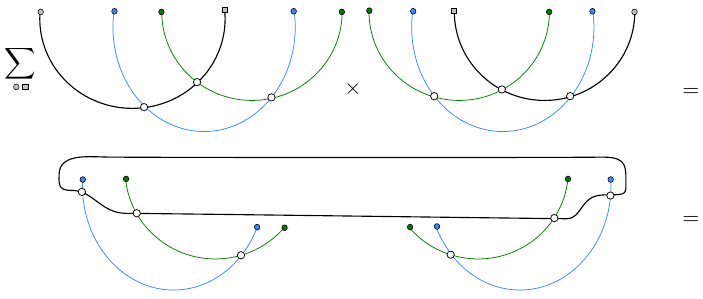
Figure 12 . The sum over the flavour indices of the mirror particle states in the matrix part of the hexagon form factor is proportional to a transfer matrix. This is precisely the same mechanism present in the OPE with just one spinning